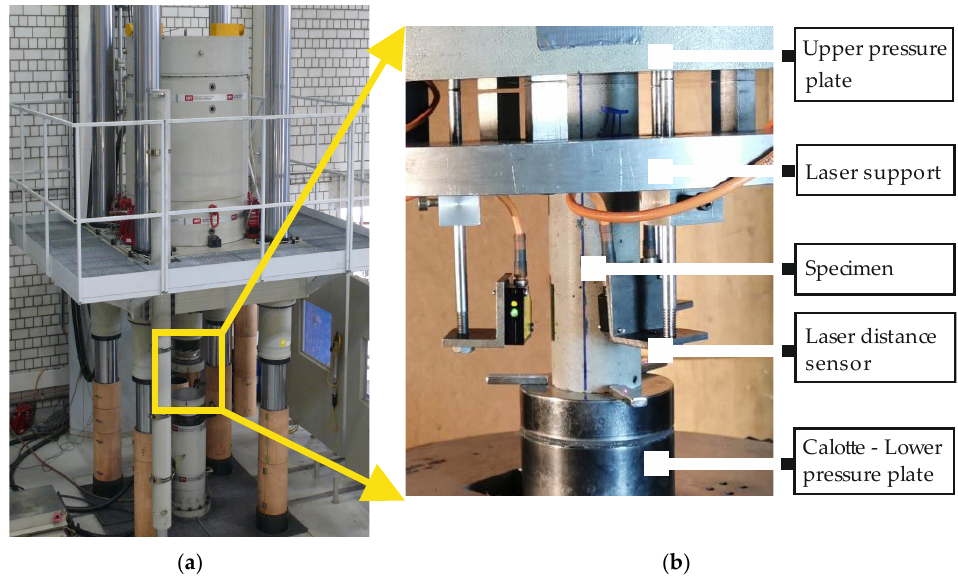
Figure 2. Test set-up at the IfB: ( a ) 1 MN servo-hydraulic actuator, ( b ) measurement set-up.